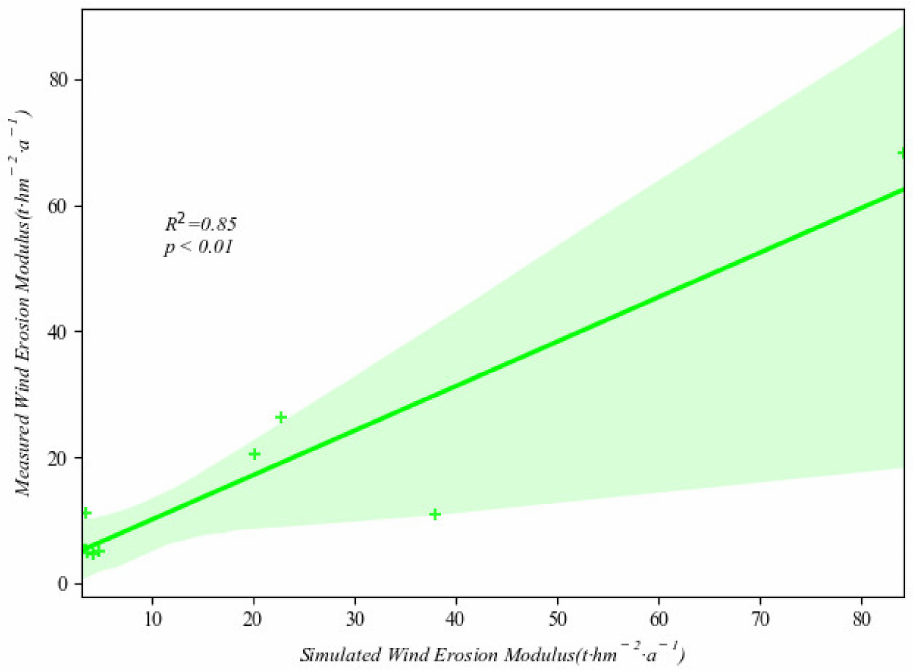
Figure 5. Verification of RWEQ-simulated wind erosion modulus and 137 Cs-measured wind erosion modulus